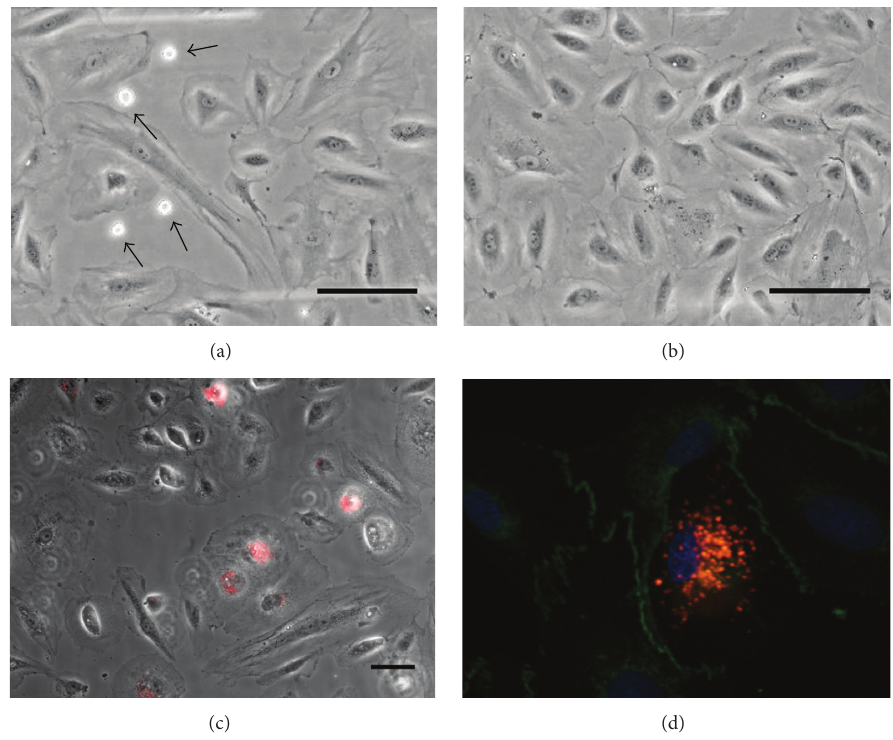
Figure 1: Representative phase-contrast live cell images of interaction of LO-EPC with 3 × 10 4 subconfluent (a) and 6 × 10 4 confluent (b) HAEC monolayers under shear stress 0.7 dyn/cm 2 . 4 × 10 5 LO-EPC were perfused for 4 min. Arrows indicated adherent LO-EPC which only adhered paracellularly at junctional regions of discontinuity between two cells in subconfluent HAEC monolayer. Scale bar 30 𝜇 m. After adhesion LO-EPC spread and establish cell-cell interaction (c). LO-EPC were labelled with DiI-Ac-LDL shown red. Scale bar 60 𝜇 m. VE-Cadherin staining revealed the formation of lateral junction between LO-EPC and HAEC (d). LO-EPC were labelled with DiI-Ac-LDL shown red and VE-Cadherin expression shown